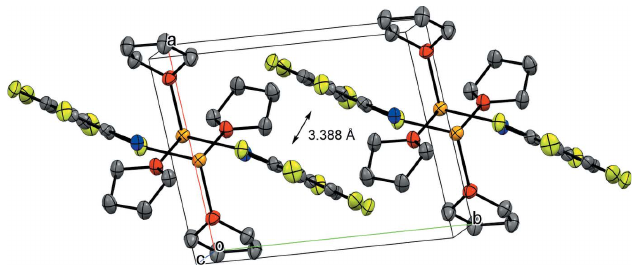
Figure 2 A packing diagram of the title compound, viewed approximately down the c axis, showing the (cid:3) – (cid:3) interaction between the C 6 F 5 rings. H atoms have been omitted.